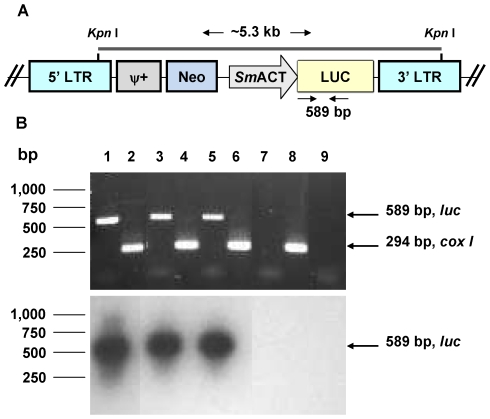
Detection by end-point PCR of retroviral transgenes in miracidia hatched from virion-transduced eggs.Panel A: Schematic representation of retroviral construct pLNHX-SmACT-Luc, showing position of Kpn I fragment employed as the hybridization probe. The retrovirus cassette included the firefly luciferase reporter gene (LUC) driven by the S. mansoni actin 1.1 gene promoter (SmACT), flanked by the 5′ and 3′ long terminal inverted repeats of the murine leukemia virus (5′LTR and 3′LTR). The cassette also included the gene endowing neomycin resistance (Neo) and the psi motif (ψ+), involved in packaging the viral DNA). Panel B: Top panel: ethidium-stained PCR products resolved in agarose gel. Genomic DNAs (gDNA) from miracidia hatched from eggs transduced with pLNHX-SmACT-Luc virions were employed as templates for PCR using primers specific for luc transgene (lanes 1, 3, 5, 7) and cox I, a positive control endogenous schistosome gene, (lanes 2, 4, 6, 8). A reaction without template gDNA with primer pairs specific for the luc gene served as the negative control (lane 9). A gDNA sample (from transduced sporocysts) known to be positive for integrated transgenes was included as the positive PCR control for luc and cox I (lanes 1, 2). The miracidia analyzed in lanes 3 (luc) and 4 (cox I) were hatched from eggs electroporated in virus, and the miracidia analyzed in lanes 5 (luc) and 6 (cox I) were hatched from eggs soaked in virus. gDNA from non-transduced, control adults (negative control) were used as template for lanes 7 (luc) and 8 (cox I). Molecular size standards in base pairs (kb) are shown at the left, while the sizes of signals for luc (589 bp) and cox 1 (294 bp) are indicated at the right. Bottom panel: autoradiograph of Southern hybridization signals from the PCR products (visualized in top panel) to a radiolabeled probe, a ∼5.3 kb Kpn I fragment of pLNHX-SmACT-Luc spanning the genes encoding neomycin resistance (neo) and firefly luciferase (luc) (panel A).